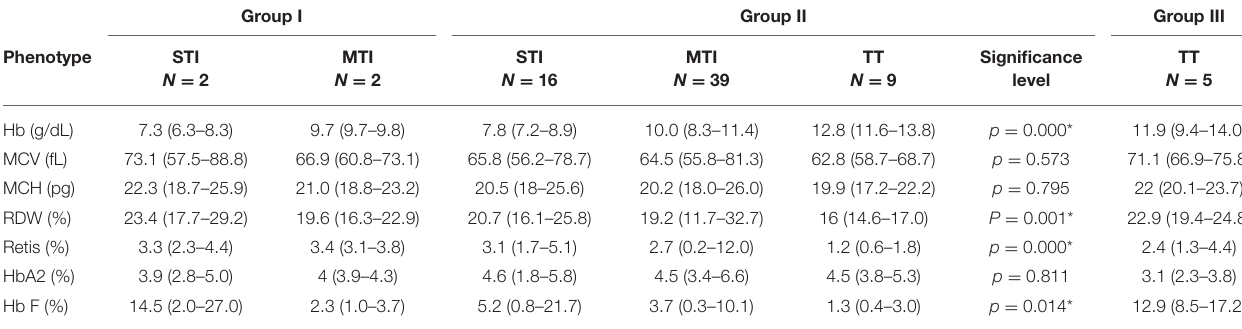
TABLE 4 | Summary of the hematological data of the different groups according to the phenotype. Group I Group II Group